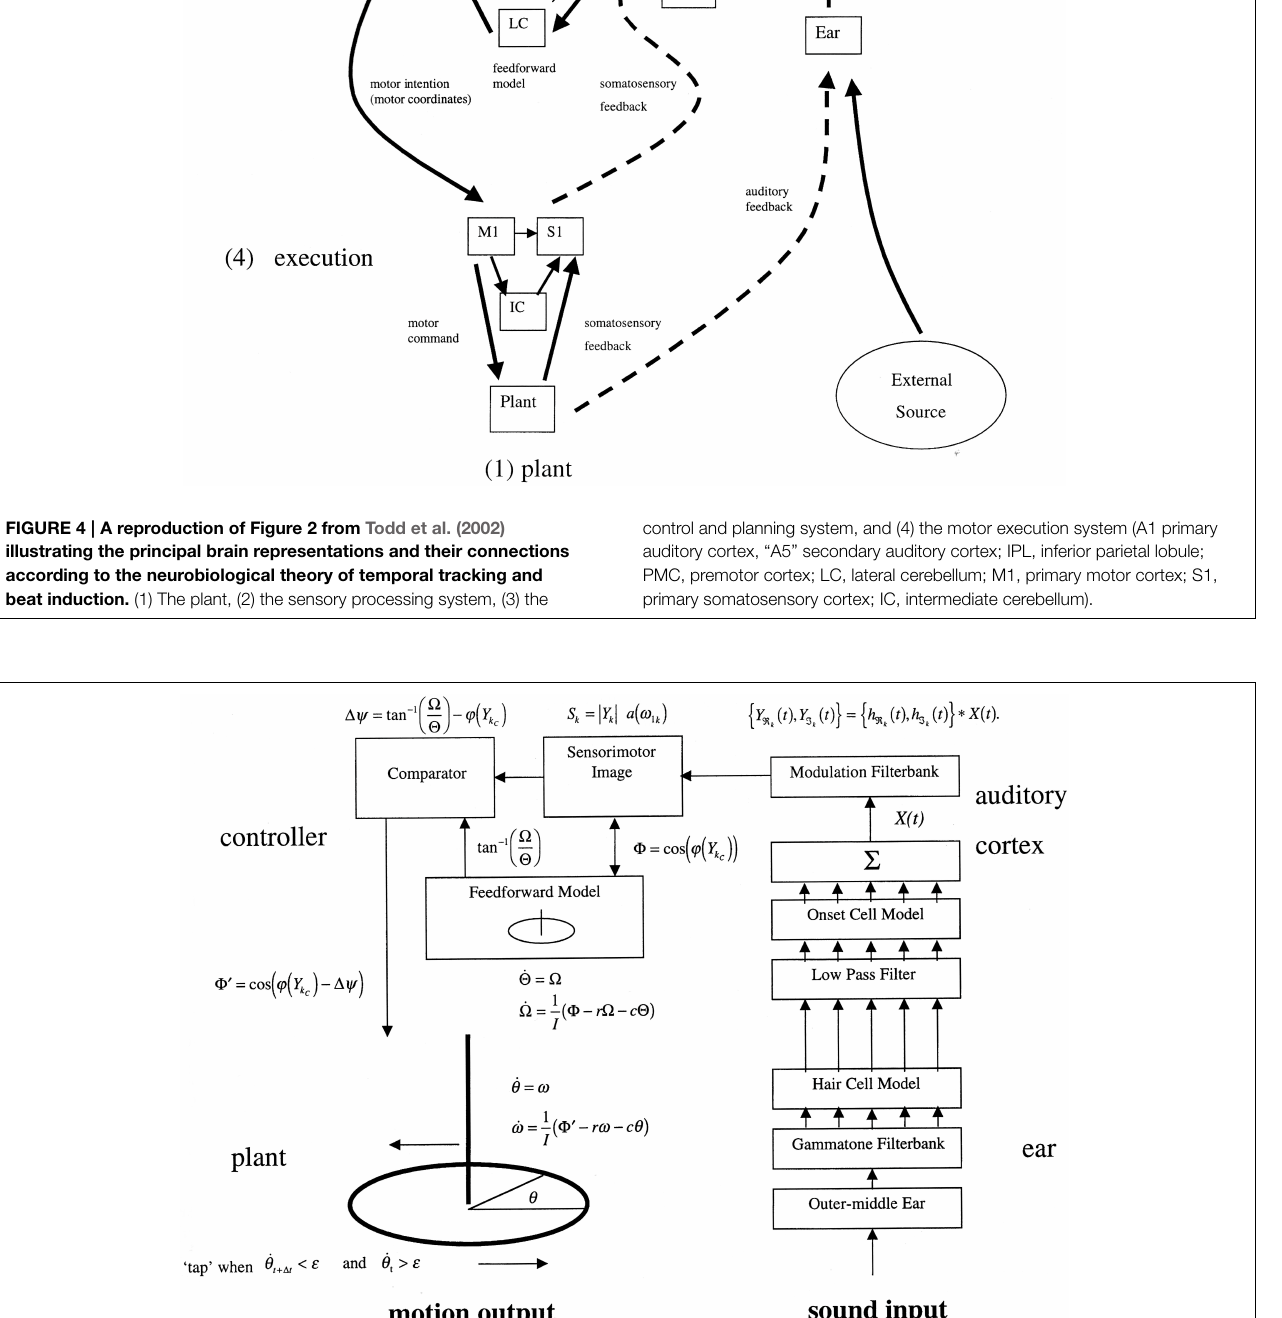
FIGURE 5 | A reproduction of Figure 3 from Todd et al. (2002) illustrating the principal elements of a computational algorithm which implements the neurobiological theory. The system is represented operating in open-loop mode, i.e., without feedback.